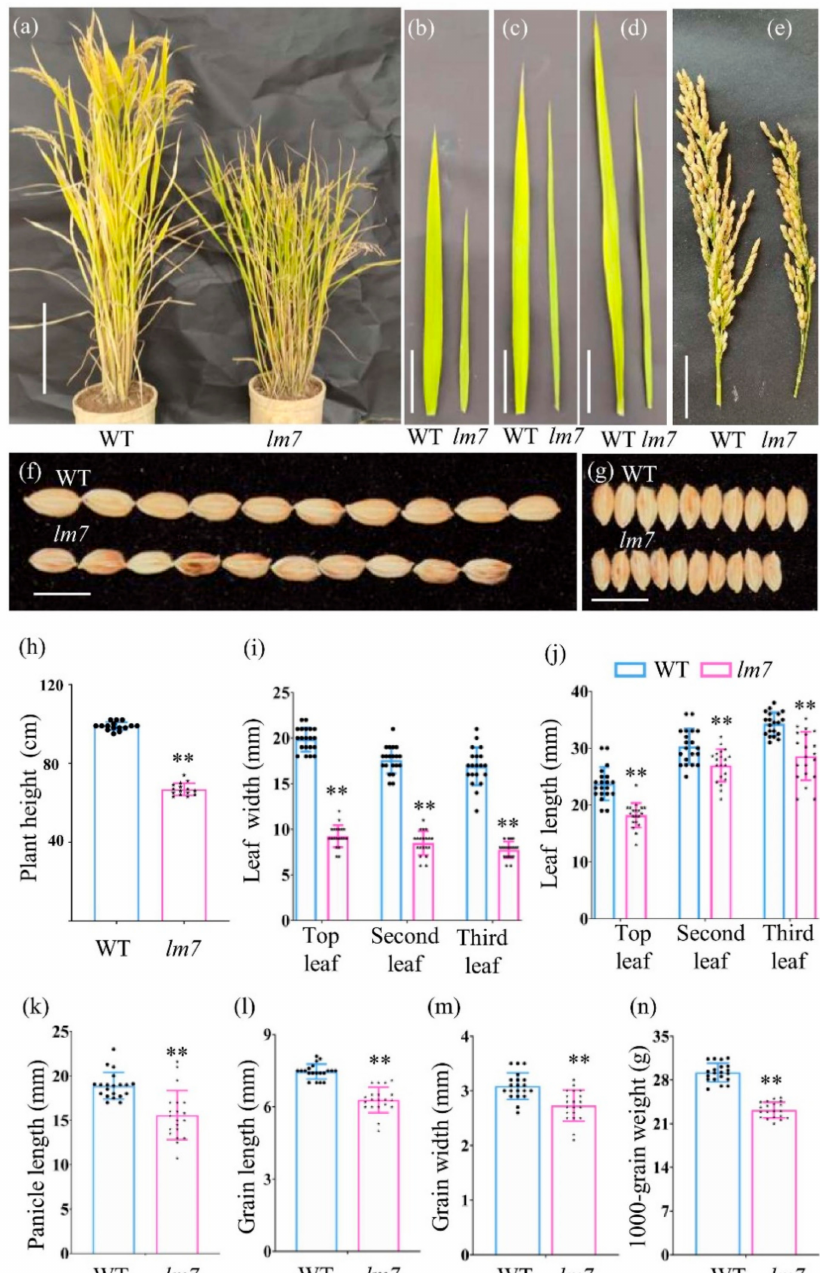
Figure 1. Phenotype characterization of lm7 . ( a ) Representative image of mature plant of wild-type (WT) Zhenggeng 1925 and lm7 . Scale bar is 20 cm. Representative image of the ( b ) top, ( c ) second, and ( d ) third leaf in WT and lm7 . Scale bar is 5 cm. Representative image of the ( e ) panicle, ( f ) grain length, and ( g ) grain width. Scale bar is 1 cm. The mean value of ( h ) plant height, ( i ) leaf width, ( j ) leaf length, ( k ) panicle length, ( l ) grain length, ( m ) grain width, and ( n ) 1000-grain weight. Significant differences compared with the WT were determined using Student’s t -test: ** p <